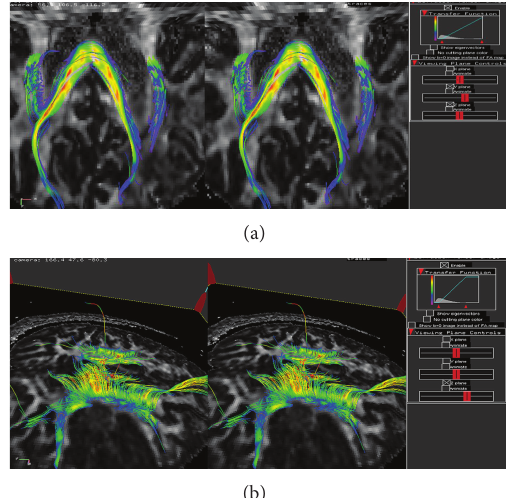
Figure 4: (a) DTI, fiber-tracking function. The fiber-tracking func- tion of the DTI visualization tool is shown stereoscopically in the left-right eye stereo views. Notice the clear spatial separation of all the overlapping tracts once stereoscopic effect is achieved. (b) DTI, stereoscopic view. Color is used to depict other DTI parameters (such as the FA values in figures above) along the